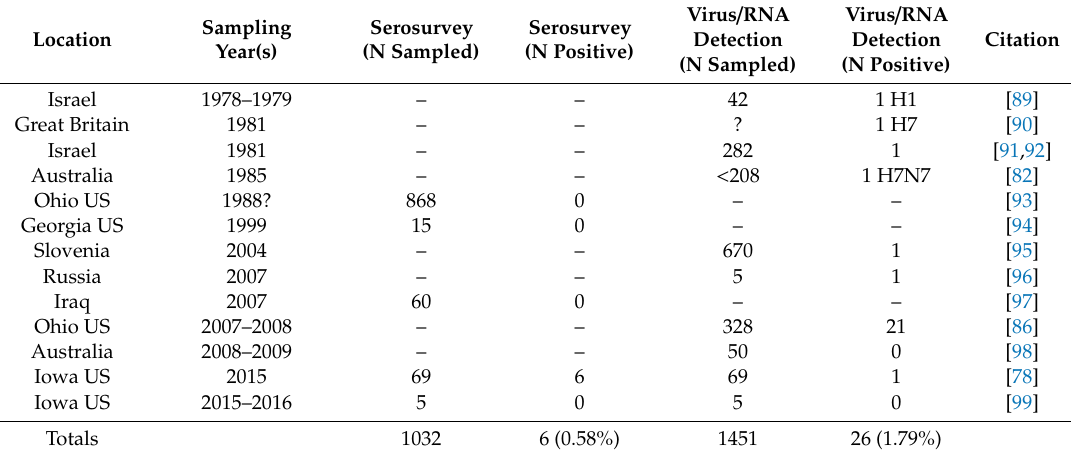
Table 2. Avian influenza A virus surveillance of European